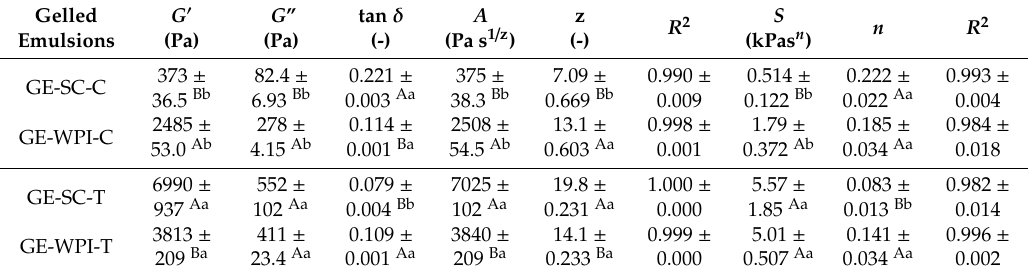
Table 2. E ff ect of emulsifying protein (EP) and condensed tannins (T) on dynamic rheological properties (at 1 Hz), weak gel model parameters and creep rheological properties of gelled emulsions (GEs). G Gelled Emulsions